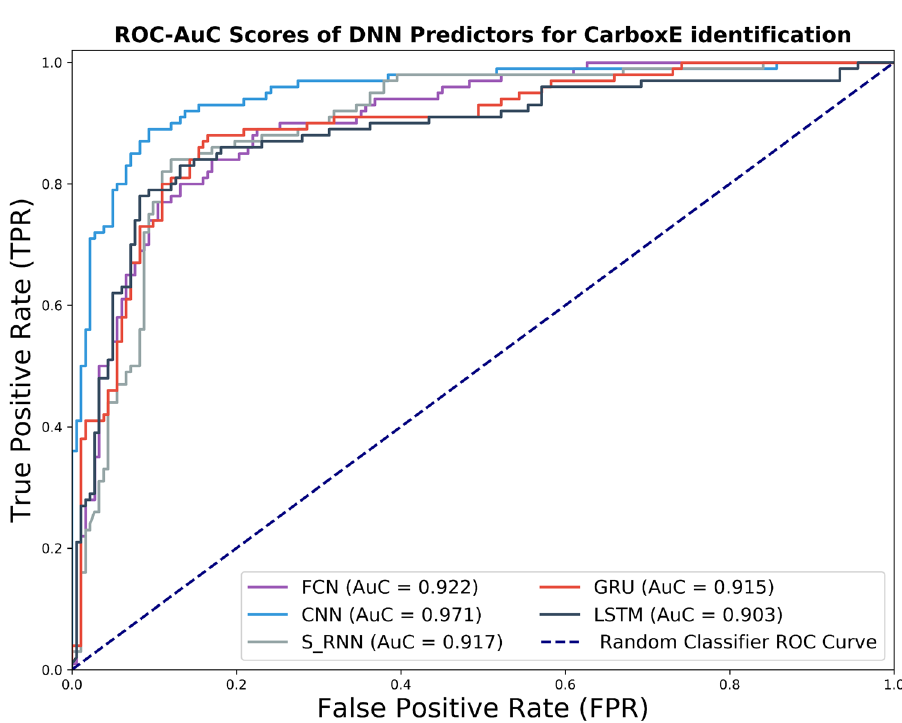
Figure 3. ROC curve and AUC scores for DNN based CarboxE site identification